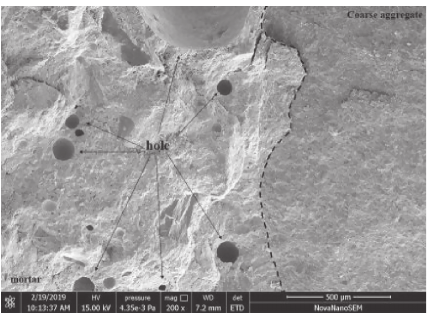
Figure 4: The SEM images of the failure ordinary concrete at 10 − 5 /s.